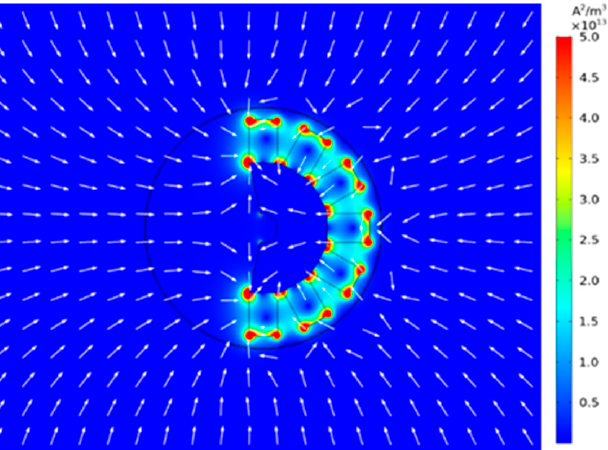
Figure 7. H · ∇H vector direction and intensity distribution cloud map. Figure 7. H ·∇ H vector direction and intensity distribution cloud map.